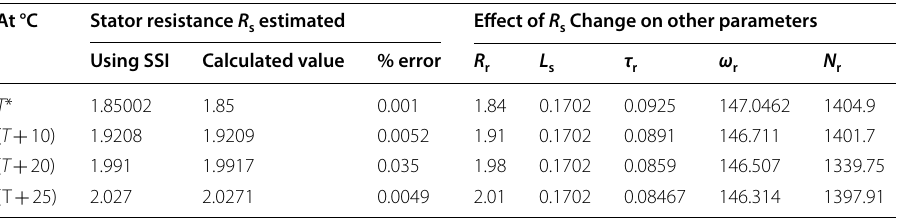
Table 3 R estimation using SSI method at various temperatures s At °C Stator resistance R s estimated Effect of R s Change on other